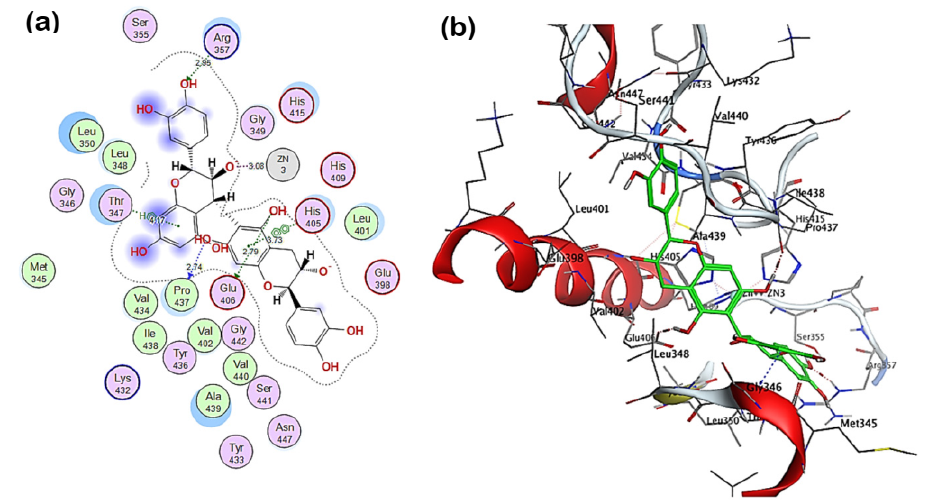
Figure 5. 2D ( a ) and 3D ( b ) interactions complex of procyanidin B6 with TACE (PDB ID: